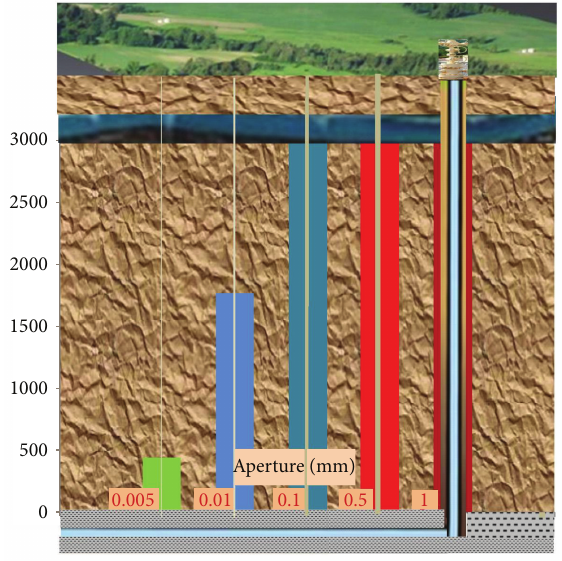
Figure16:Verticalparallelmodelplatemodelfordifferentapertures for a period of 47.5 years. The upward movement of water together with pollution could be very rapid in the case where there aperture size is very large (e.g; > 1mm) and very slow for small apertures (converging to typical matrix diameter void opening).